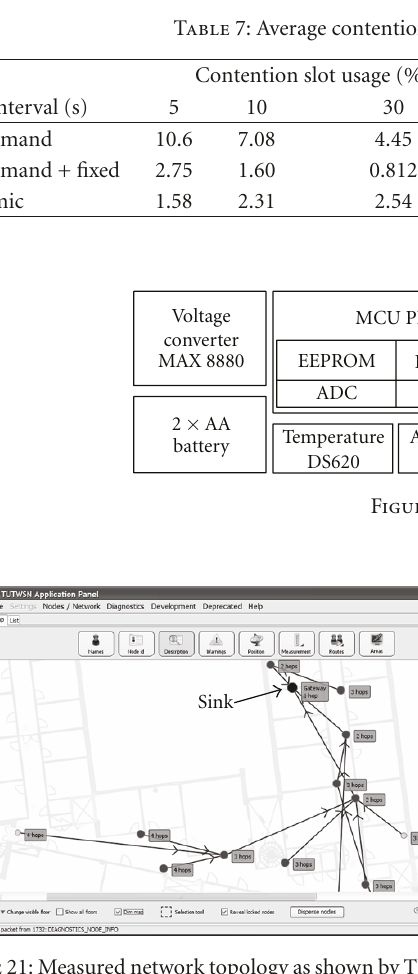
Figure 21: Measured network topology as shown by TUTWSN user interface.